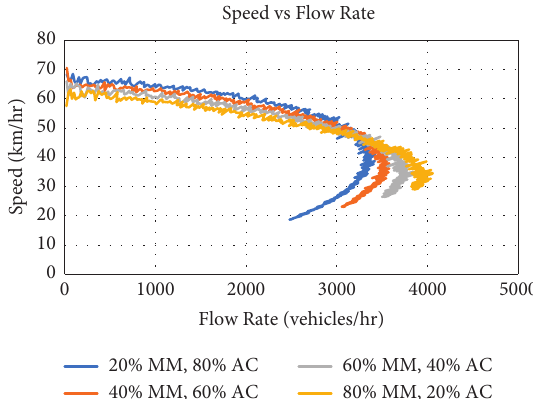
Figure 32: Speed vs. flow rate fundamental diagrams for different compositions of MM and AC.